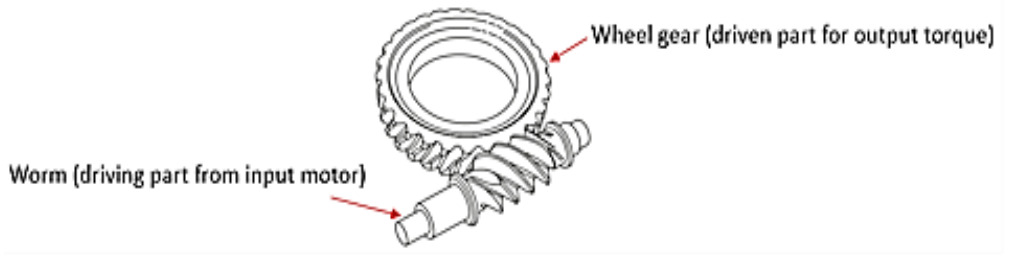
Figure 4. A schematic diagram of worm gear drive